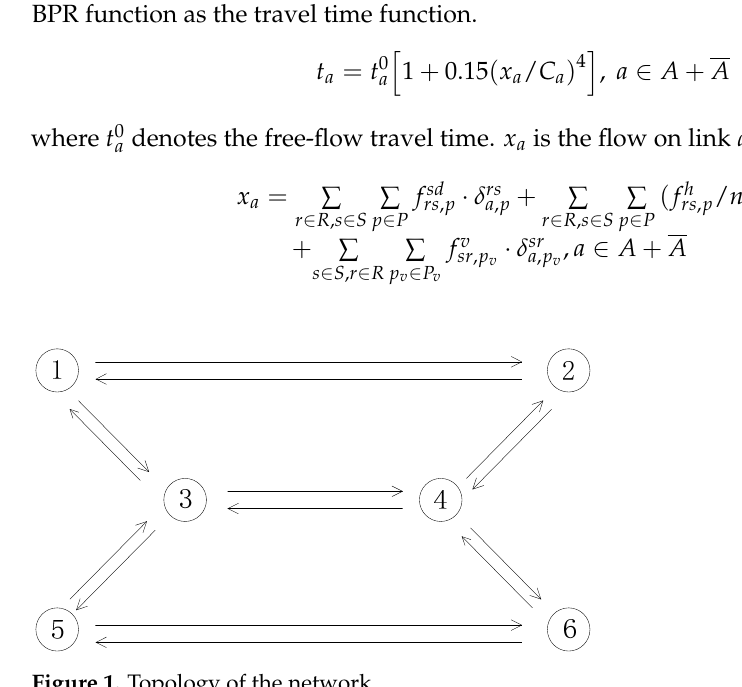
Figure 1. Topology of the network. Table 1. Travel demand of the network.